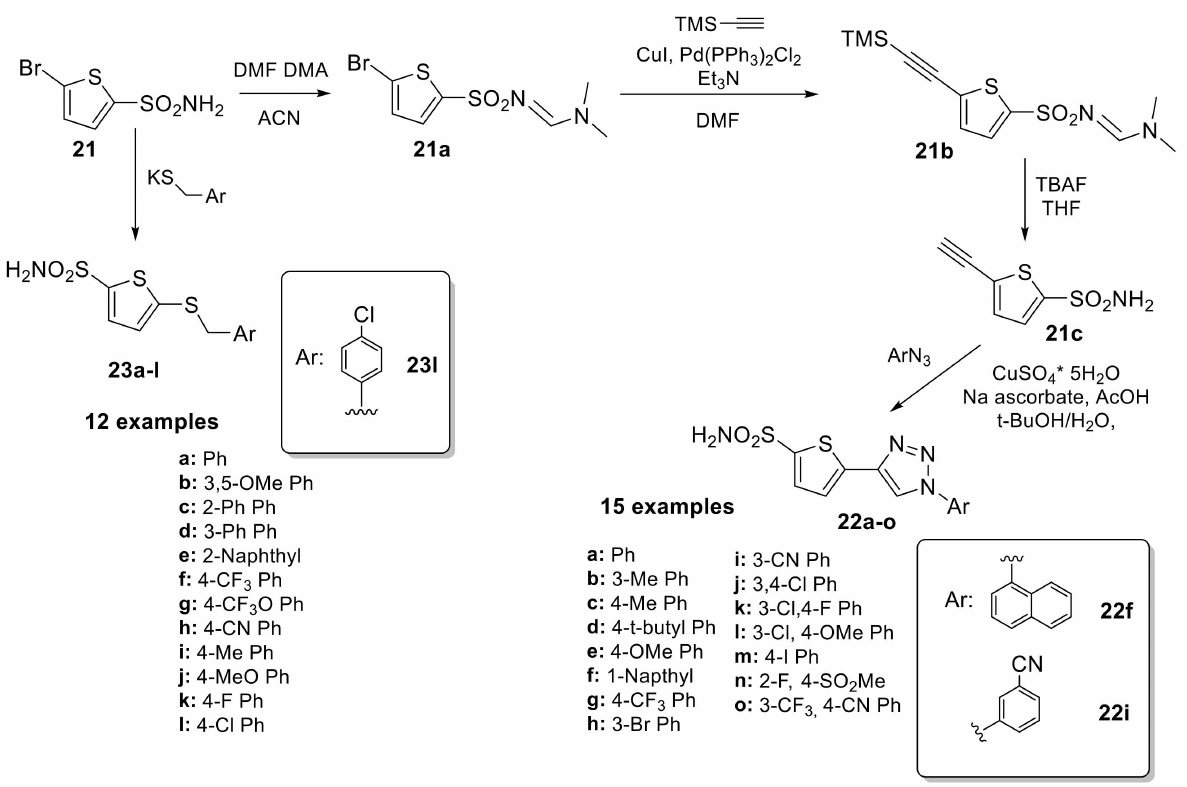
Scheme 6. Synthesis of thiophene sulfonamides reported by Leitans et